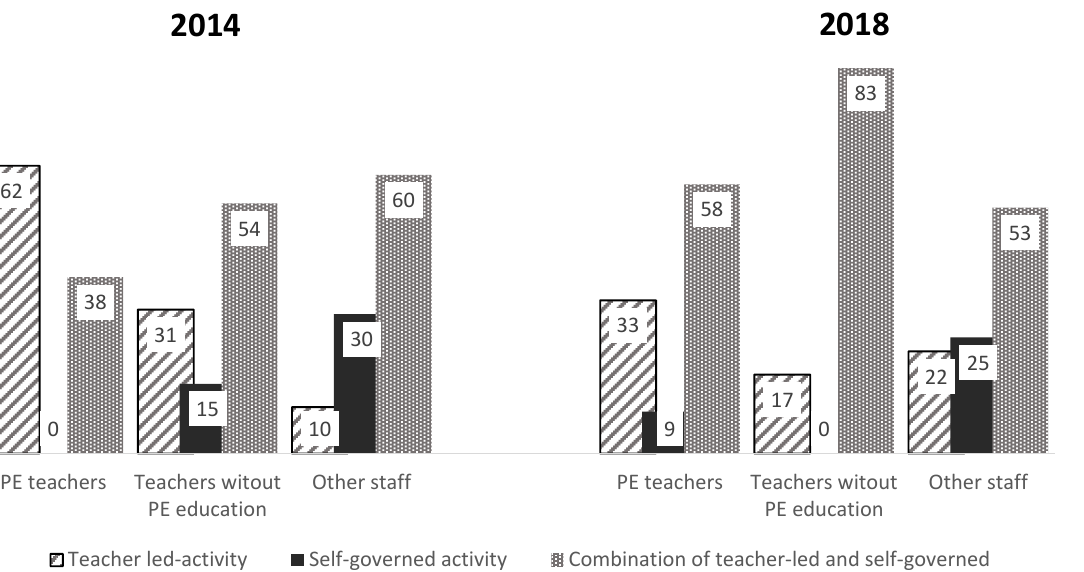
Figure 3. An overview of the kind of staff and the means of organizing (percentage distribution) in PA classes in 2014 ( n = 69) and 2018 ( n = 65). Significant differences between how different staff organized the lessons in 2014 ( p = 0.001) were observed.